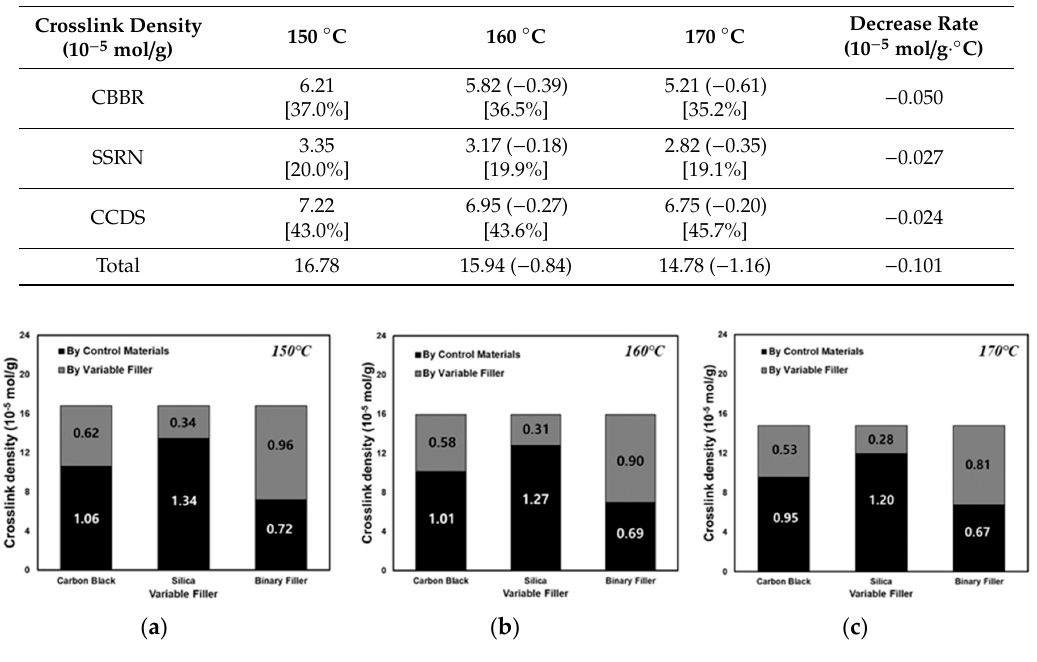
Figure 5. Analysis of the vulcanizate structures of the T-3 compound according to filler variates at different cure temperatures of ( a ) 150, ( b ) 160, and ( c ) 170 °C. Table 4. Vulcanizate structure of the SBR binary compound (T-3) at different cure temperatures.